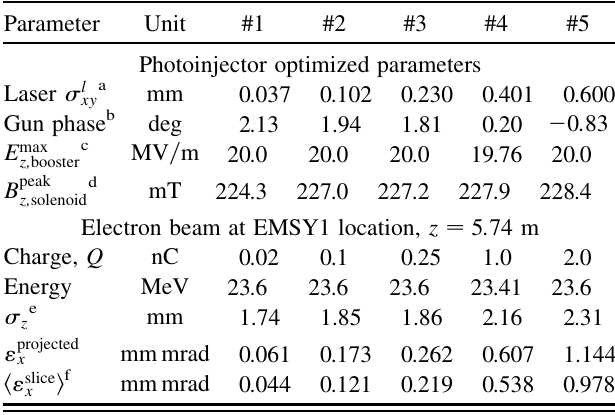
TABLE I. Optimum simulated photoinjector parameters for various bunch charges.